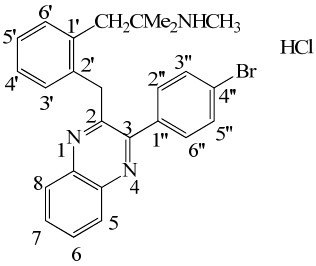
Figure 10. Chemical structure of compound 2g .